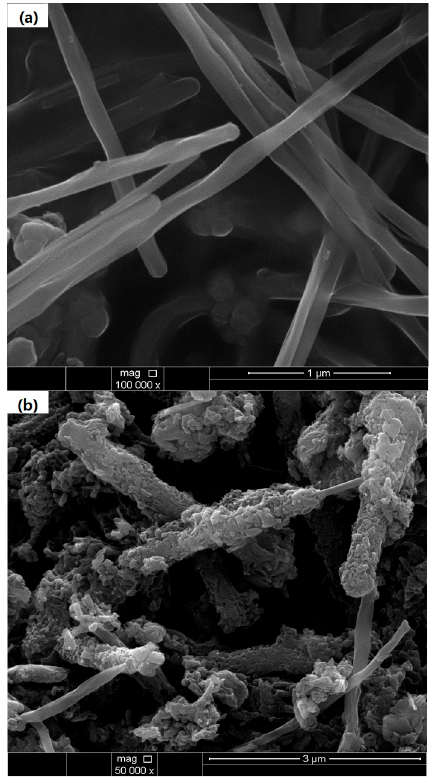
Figure 1. SEM of MWCNTs ( a ) and PANI/F-MWCNTs ( b ).